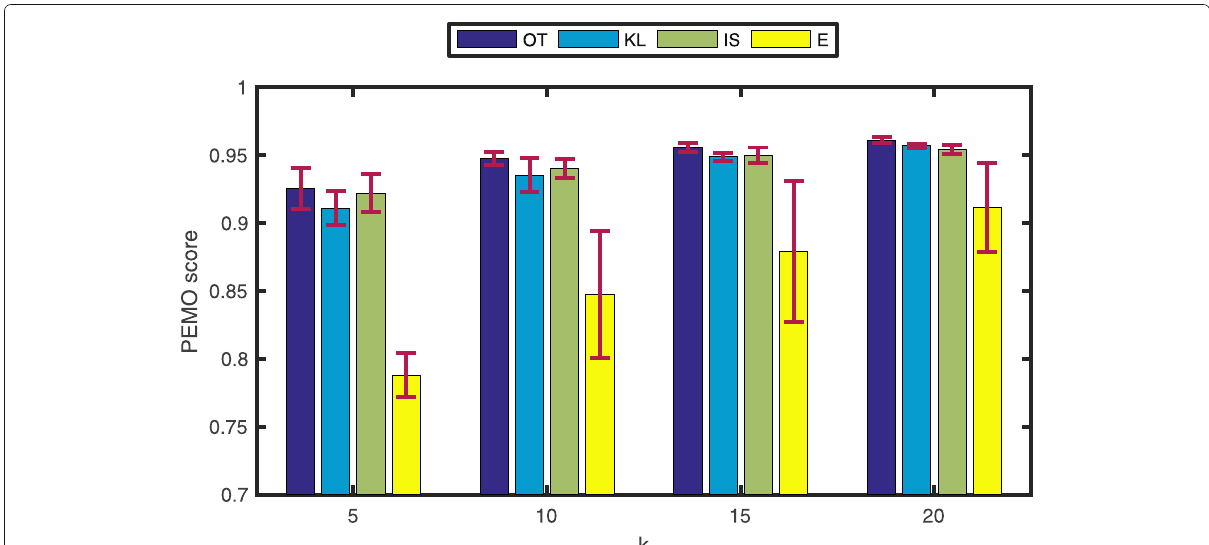
Fig. 4 Perceptive quality score (personal voice model). Average and standard deviation of PEMO scores of reconstructed isolated voices, where the model is learned using separate training data for each voice with optimal transport (dark blue), Kullback-Leibler (light blue), Itakura-Saito (green), or Euclidean (yellow) NMF